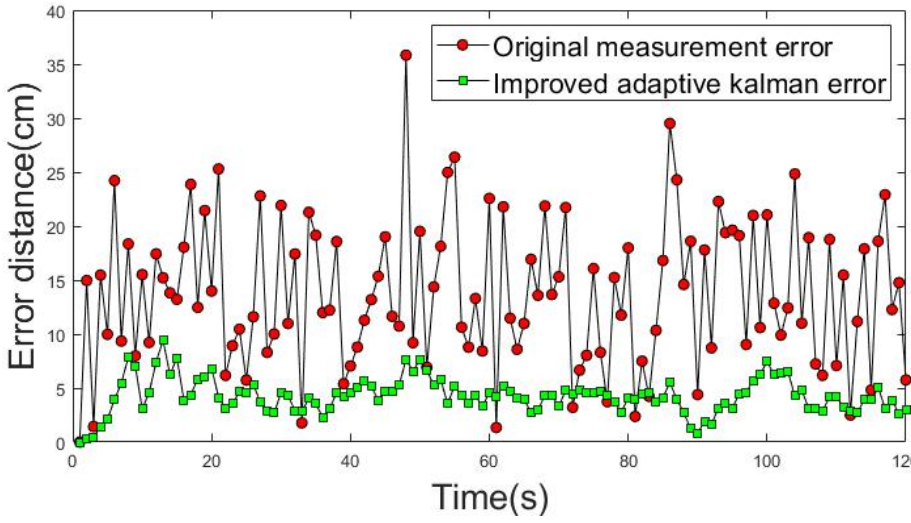
Figure 15. Shift error distance analysis of movement trajectory 1.